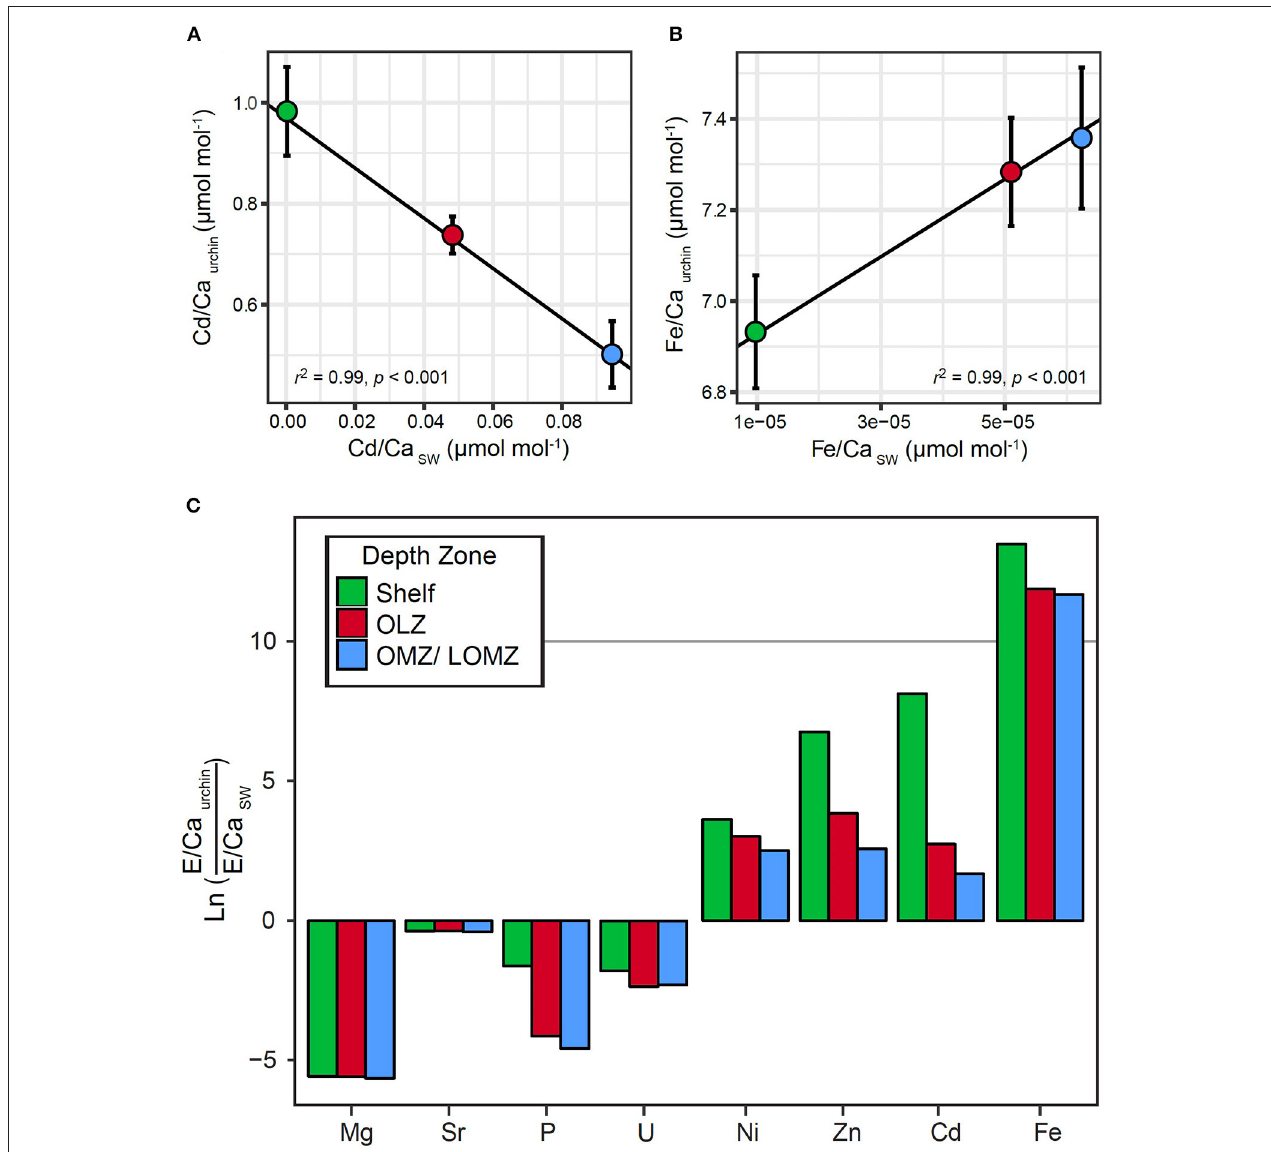
FIGURE 4 | Relationships between element to calcium ratios in Strongylocentrotus fragilis test plates (E/Ca urchin ) and element to calcium ratios in seawater (E/Ca SW ) within different depth zones. E/Ca urchin were averaged across depth bins, Shelf (green), Oxygen Limited Zone (red), and Oxygen Minimum Zone / LOMZ (blue). Black lines indicate significant linear regression relationships which yielded empirical partition coefficients (D metal ) for (A) Cd and (B) Fe. Error bars indicate ± 1 standard error. (C) Natural log-transformed ratios of elemental incorporation in Strongylocentrotus fragilis E/Ca Urchin versus element concentration ratios in seawater E/Ca SW . Ln values > 0 indicate E/Ca Urchin > E/Ca SW . Values < 0 indicate E/Ca Urchin < E/Ca SW . Elemental concentrations of various elements in seawater (Mg, Sr, P, U, Ni, Zn, Cd, Fe, and Ca) in the upper 1,000m of the water column were extracted from Biller and Bruland (2013) and Dr. Kenneth Johnson’s Periodic Table of Elements in the Ocean. Available online at: